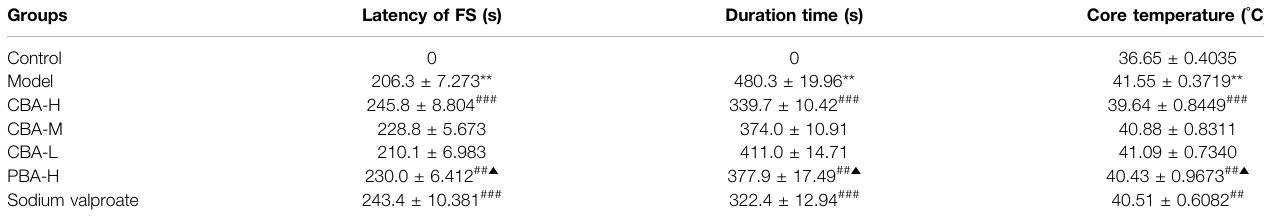
TABLE 3 | The effect of bile Arisaema (BA) administration on the latency, duration time, recovery time, and core temperature in a febrile seizure (FS) rat model. Groups